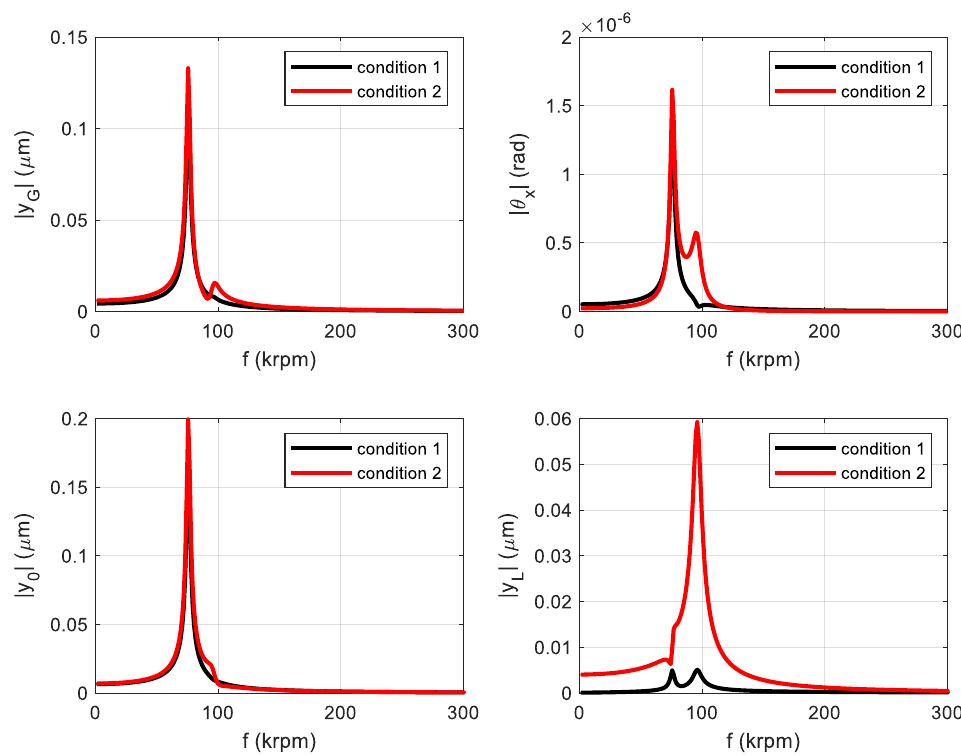
Figure 13. Examples of frequency spectra of signals y G , y 0 , θ x and y L obtained from the orbit method.